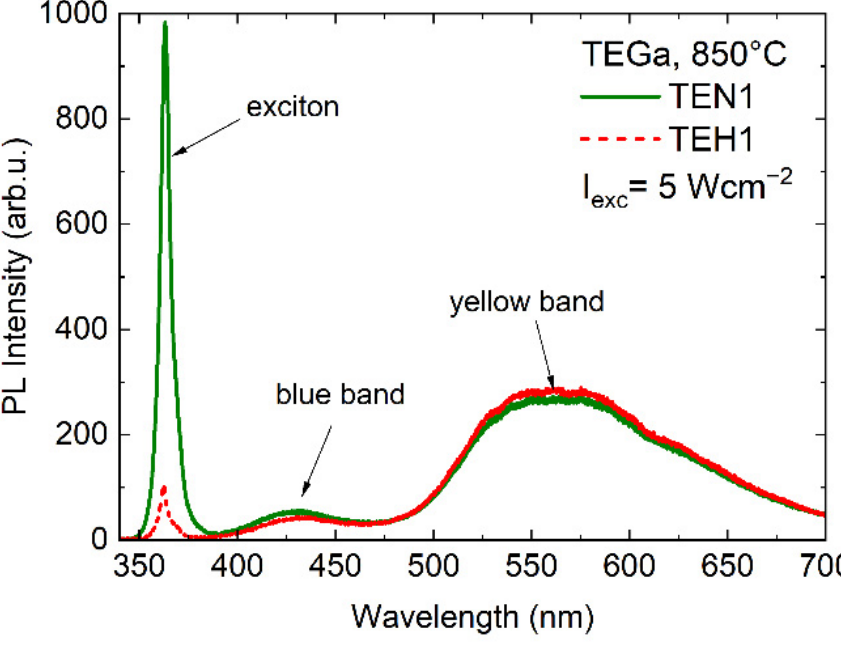
Figure 8. Room-temperature photoluminescence spectra of samples TEN1 and TEH1. In Figure 9a,b, correlation between excitonic and YB intensity with respect to the V Ga concentration is shown, summarizing the data obtained from all studied layers. No correlation between V Ga concentration and YB luminescence intensity was observed, which suggests that V Ga are not the dominant reason for YB